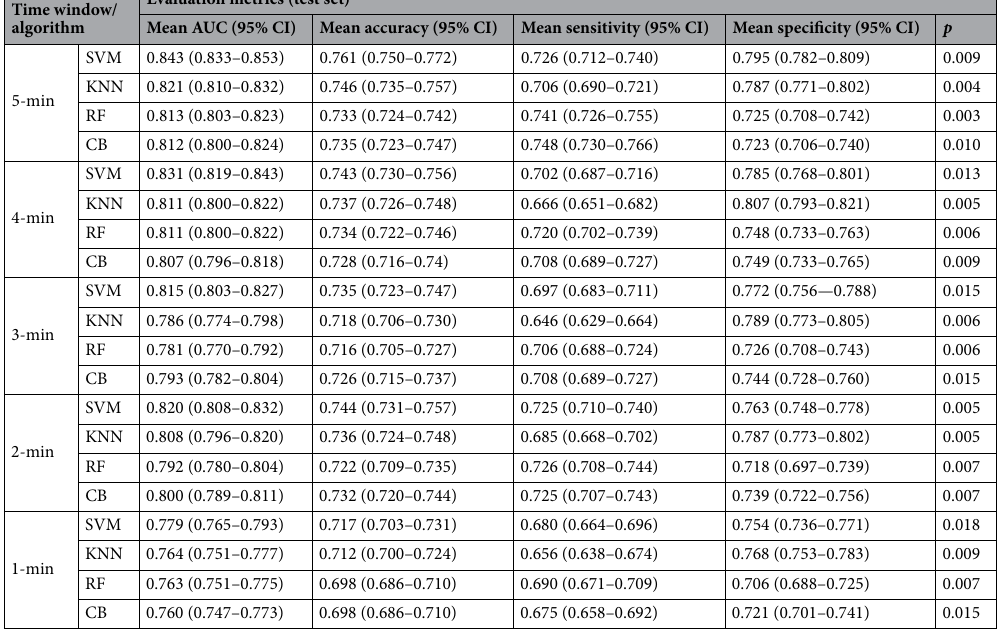
Table 1. Results of the classifiers trained on task related HRV. AUC area under the receiver operating characteristic curve, CB CatBoost classifier, CI confidence interval, KNN k-nearest neighbors, p permutation test p-value, RF random forest, SVM support vector machine.